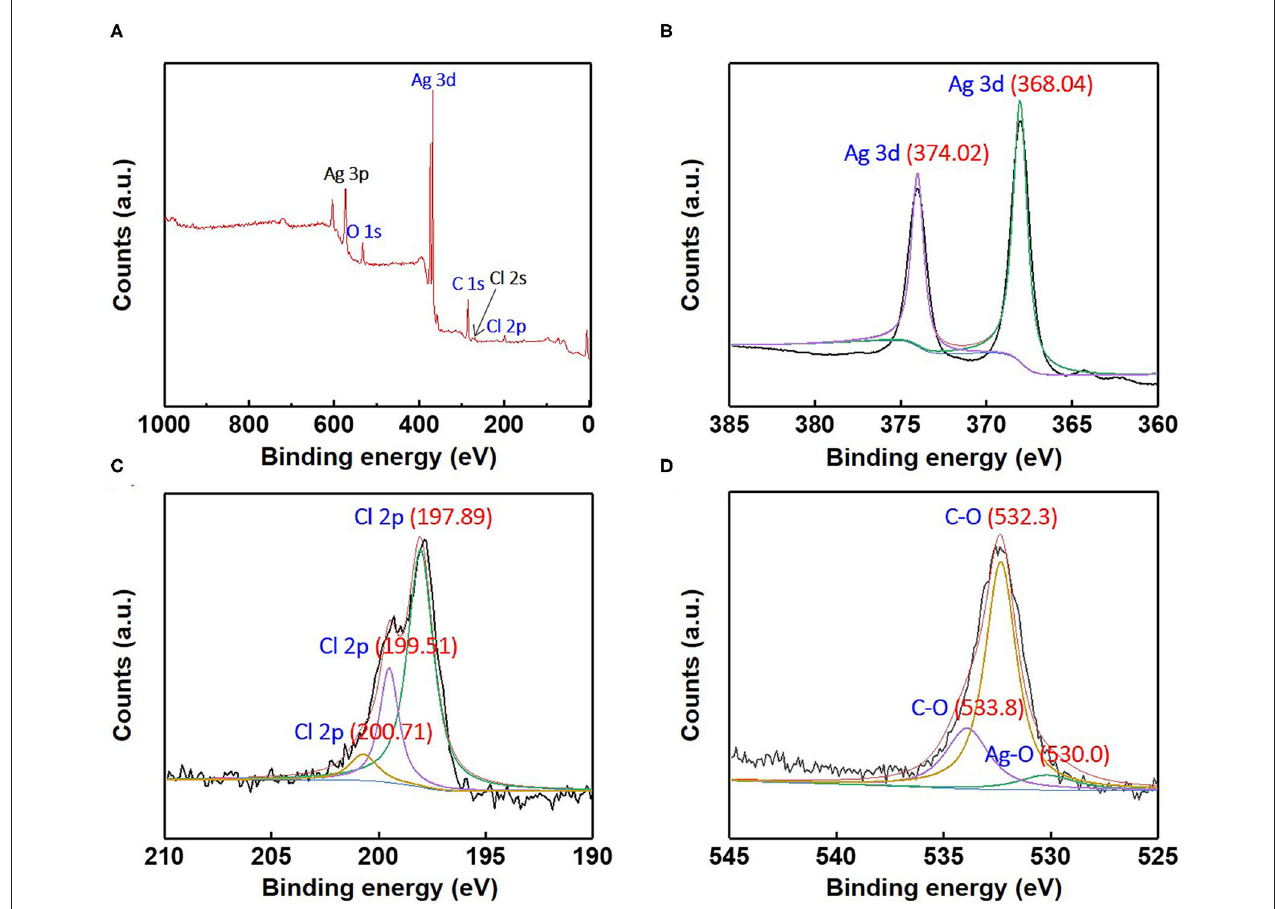
FIGURE 7 | (A) X-ray photoelectron survey spectra and high-resolution X-ray photoelectron; (B) Ag3d, (C) Cl2p, and (D) O1s spectra for the as-synthesized Ag/AgCl wire.